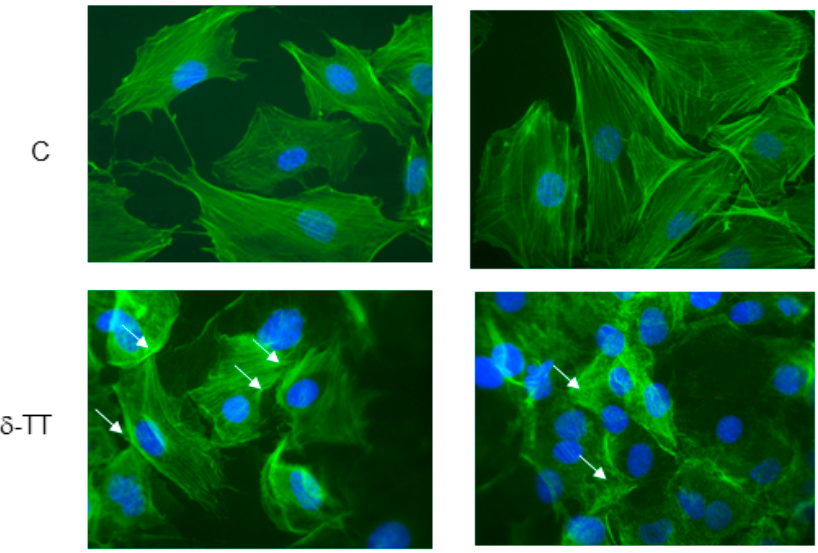
Figure 3. δ -TT (10 µ g / mL) induces cytoskeleton remodeling in MC3T3E1. We have performed the staining for F-actin (using FITC phalloidin) to visualize the cytoskeleton remodeling (white arrow). The nuclei were stained with DAPI. Magnification 40 × in a Zeiss Axiovert microscope equipped for fluorescence analysis with the corresponding sets of filters to detect FITC and DAPI emission.